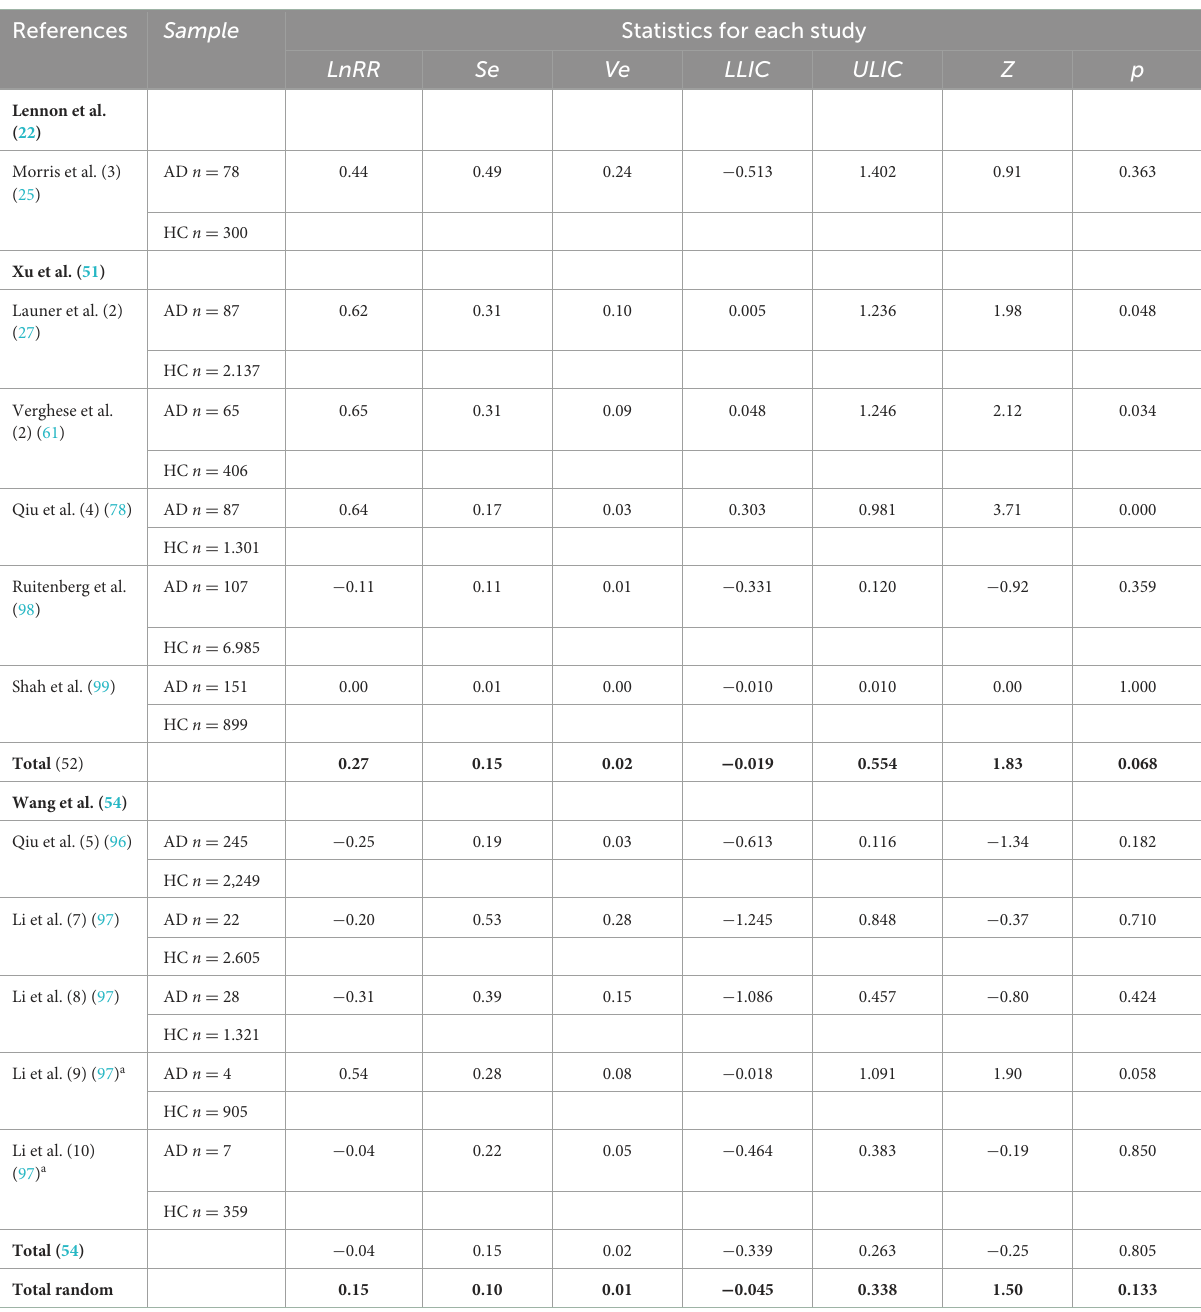
TABLE 3 Individual and pooled estimates of the association between high DBP and